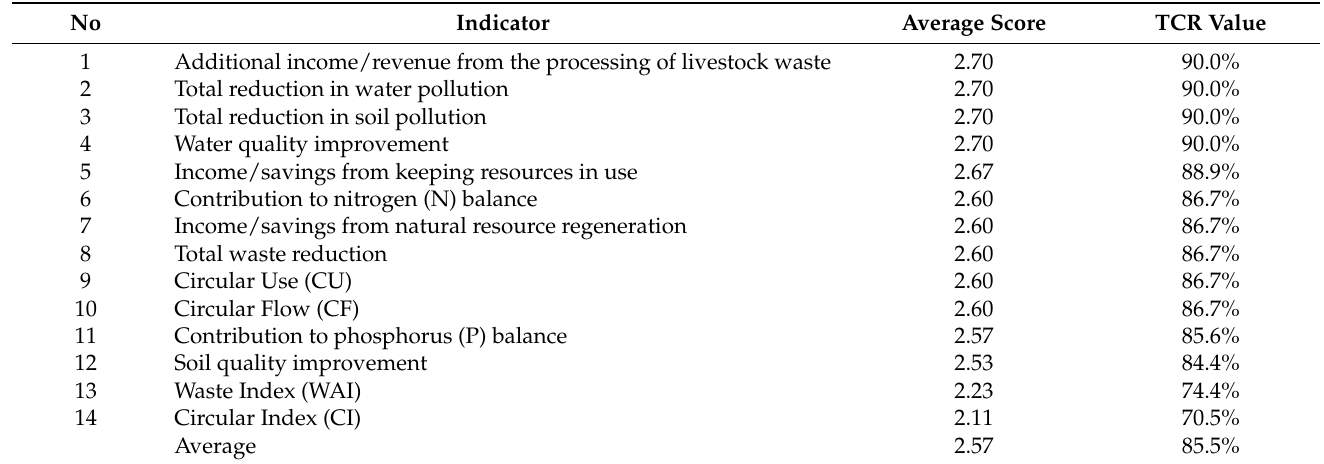
Table 4. Scoring Results of Circular Performance Indicators